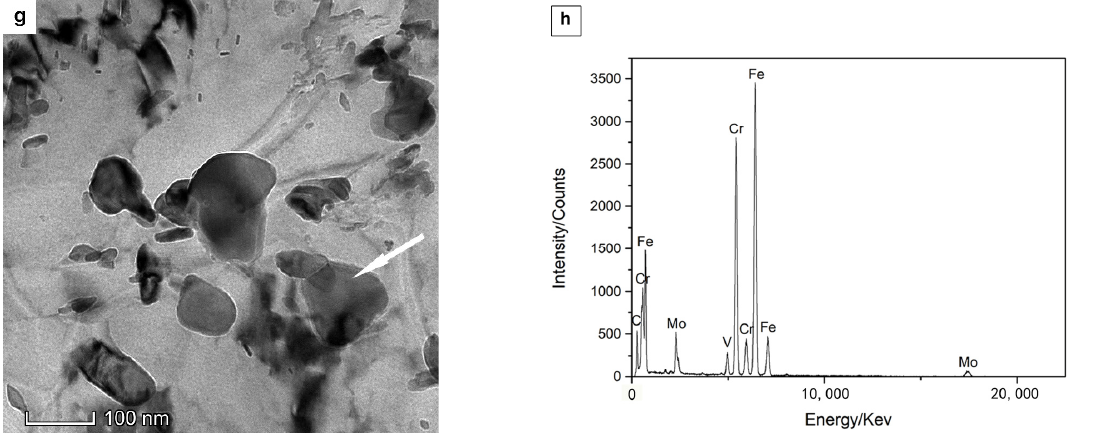
Figure 6. TEM images showing the different carbides present in the Dievar steel after tempering for 600 °C for different tempering times: ( a ) the spherical carbide (4 h); ( b ) EDX spectra for the spherical carbide in ( a ); ( c ) the smaller elliptical carbide (4 h); ( d ) EDX spectra for the elliptical (indicated by the white arrows) carbide in ( c ); ( e ) the elliptical carbide (16 h); ( f ) EDX spectra for the elliptical carbide (indicated by the white arrows) in ( e ); ( g ) different carbides with different shapes (24 h); ( h ) EDX spectra for the elliptical carbide (indicated by the white arrows) in ( g ). Table 4. The M to Fe ratio Y M (M = Cr, Mo, and V) for the different carbides in Figure 7 from the EDS measurements on tempering at 600 °C.